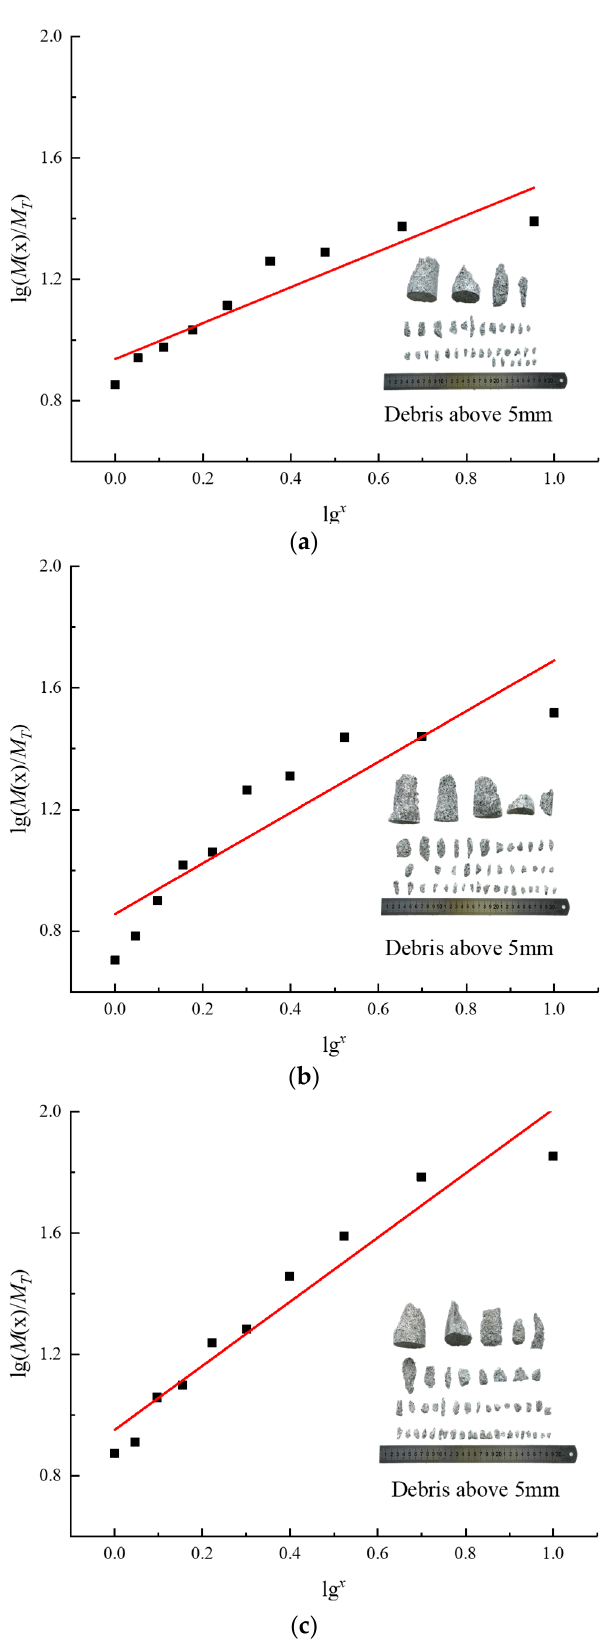
Figure 14. The log( M ( x )/ M T )–log x lines of rocks under 70% of the UCS: ( a ) 20 MPa; ( b ) 30 MPa; ( c ) 40 MPa.